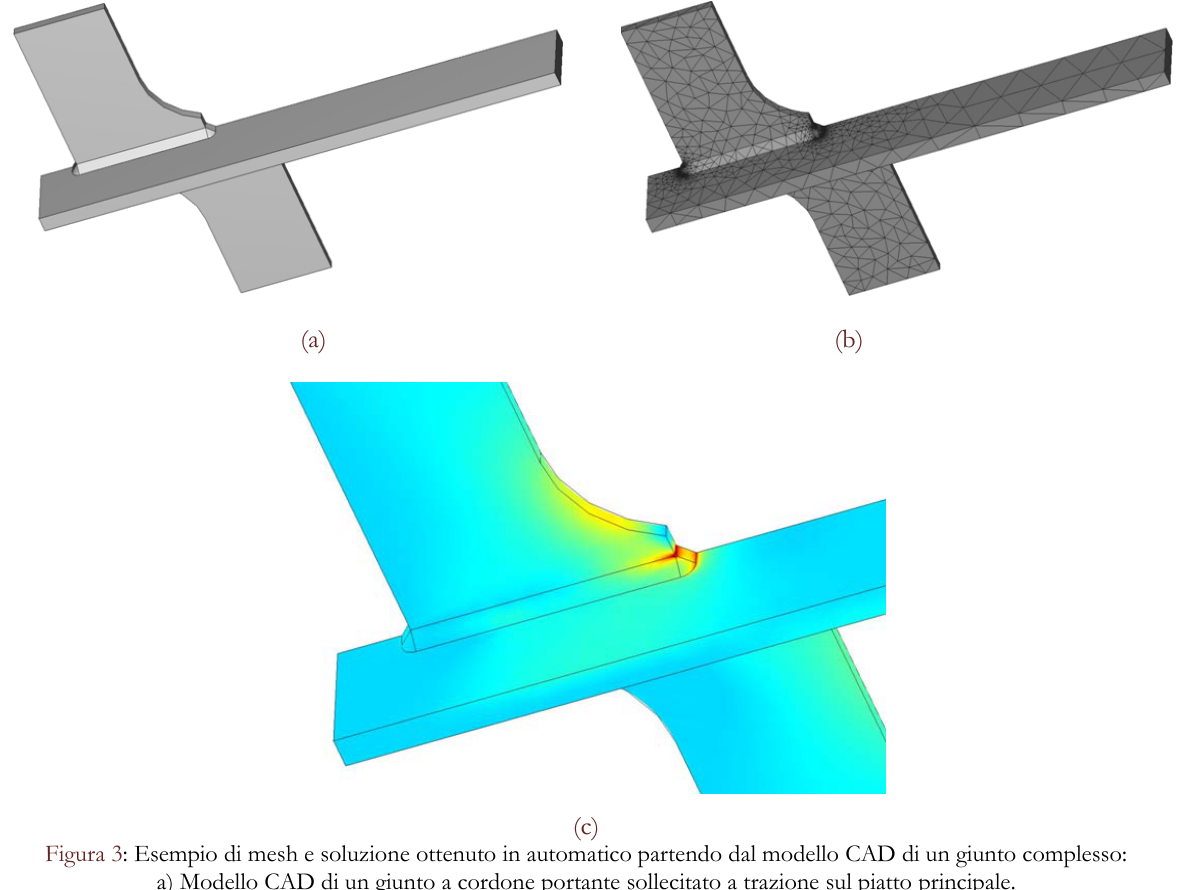
Figura 3: Esempio di mesh e soluzione ottenuto in automatico partendo dal modello CAD di un giunto